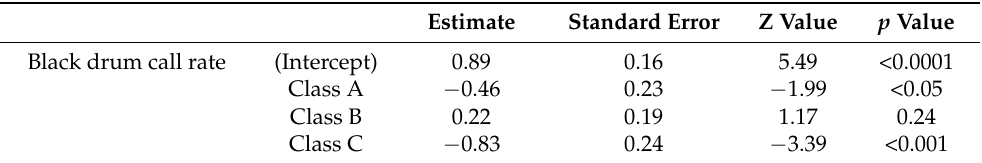
Figure 6. Boxplot of black drum call rates in the absence of boat noise (class N) and during boat noise of Classes A, B, and C. The line indicates the median, the box indicates the 25th–75th percentile, and the buffers indicate the non-outlier range. The estimated variation of the call rate for different classes of boat noise with respect to the absence of boat noise is reported in Table 2. There was a total of 561 calls for Class A, 1857 for Class B, 323 for Class C, and 22,862 for Class N. Table 2. Results of the linear mixed model (LMM) on black drum call rates among the absence of boat noise (Class N) and the presence of noise from Classes A, B, and C, considering the day and hour variables as random factors.